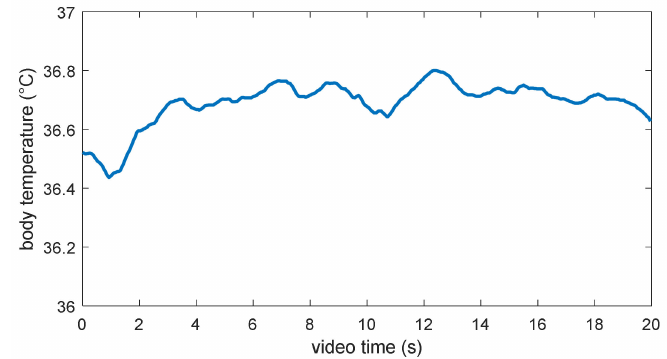
Figure 8. Estimation of body temperature from the eye corners’